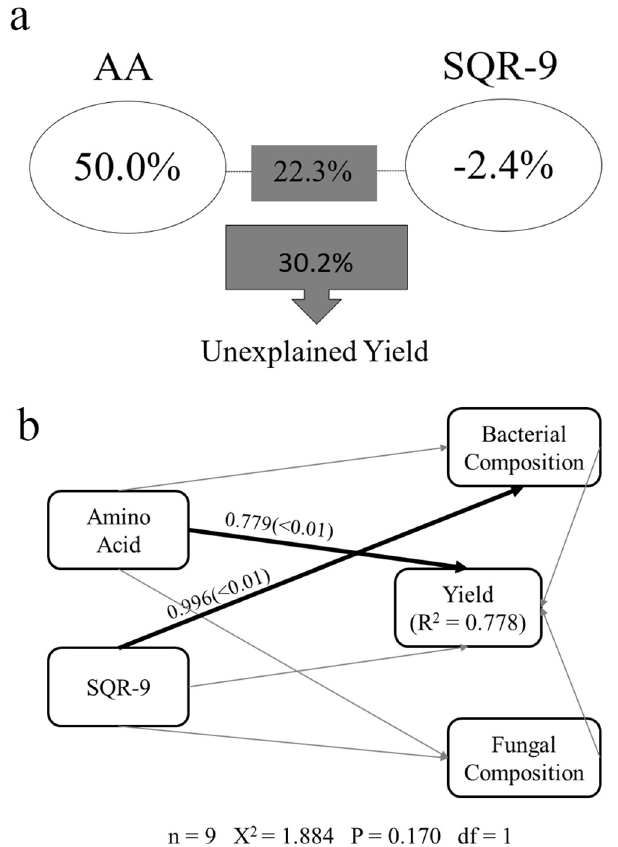
Fig 4. Mechanism of crop yield promotion. Variance partitioning analysis (VPA) map of the effects of amino acids, SQR9 and their interactions on the crop yields (a) and Structural Equation Modeling (SEM) analysis of a hypothesized network of linkages among amino acids, SQR9, bacterial composition, fungal composition and crop yield. AA, amino acids fertilizer; SQR9, functional PGPR strain SQR9 (b). The index was constructed by 0 when the factor was inexistence and 1 when the factor was